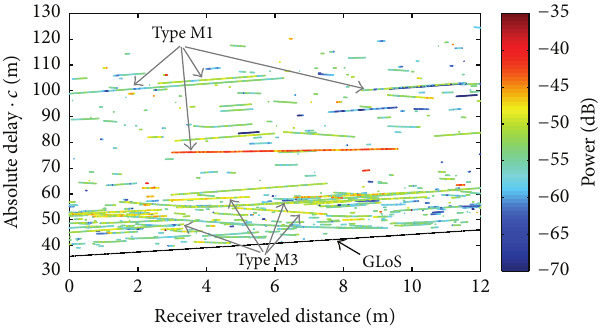
Figure 17: Example of generated time variant CIRs. Some examples of modeled MPCs of types M1 and M3 are marked. It is worth mentioning that the delays are independent of the type of the MPCs. For instance, there are also few MPCs of type M1 with shorter delays but not marked in the figure due to visualization